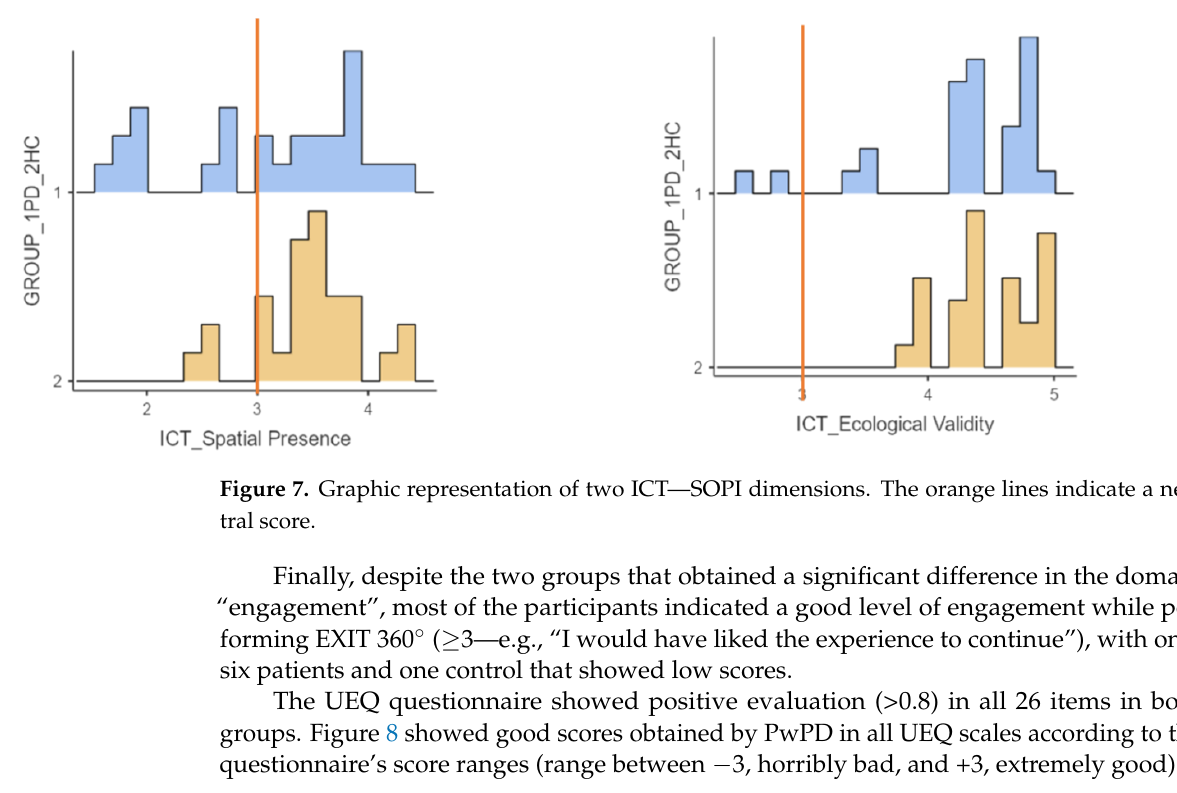
Ecological Validity Negative Effects 1.29 ± 0.42 1.2 ± 0.26 0.361